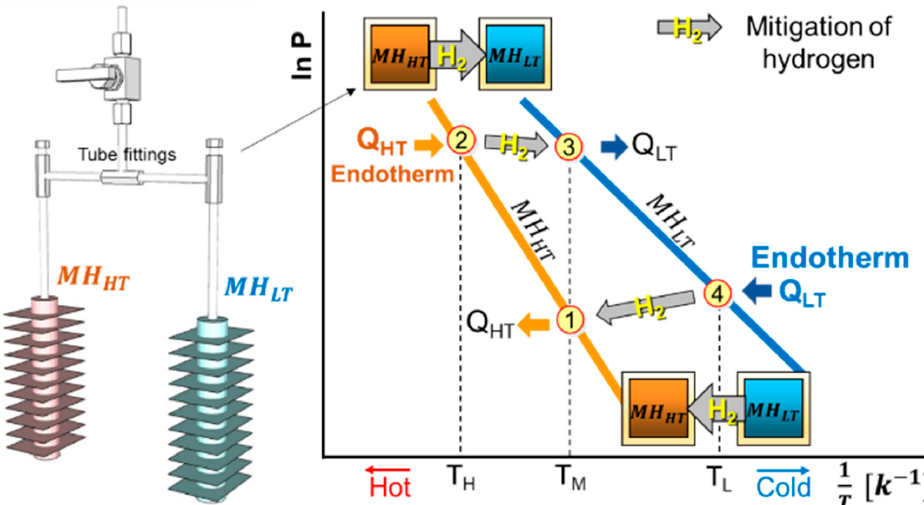
Figure 2. The actual metal hydride reactor pair used in the experimental setup shown in Figure 4 ( left ); The thermodynamic cycle diagram of an MHHP system illustrated on the van’t Hoff plot for an arbitrary metal hydride pair ( right ). The numbers in the red circle indicate each state. The arrows connecting States 2–3 and States 4–1 indicate the hydrogen migration between the reactors with relevant endotherm and exotherm. Energies 2020 , 13 , x FOR PEER REVIEW